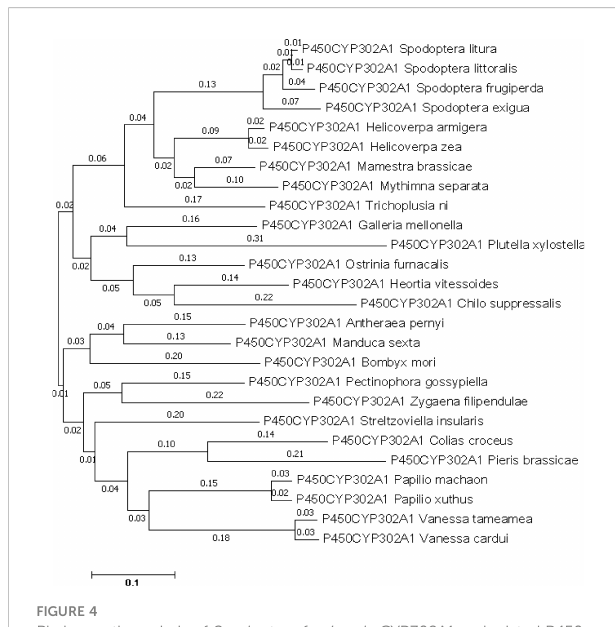
FIGURE 4 Phylogenetic analysis of Spodoptera frugiperda CYP302A1 and related P450s. A phylogenetic tree was constructed by the neighbor joining (NJ) method using Mega 7.0 software. The scale bar indicates 0.1 amino acid substitutions per site. Bootstrap analysis was performed with 1000 iterations.